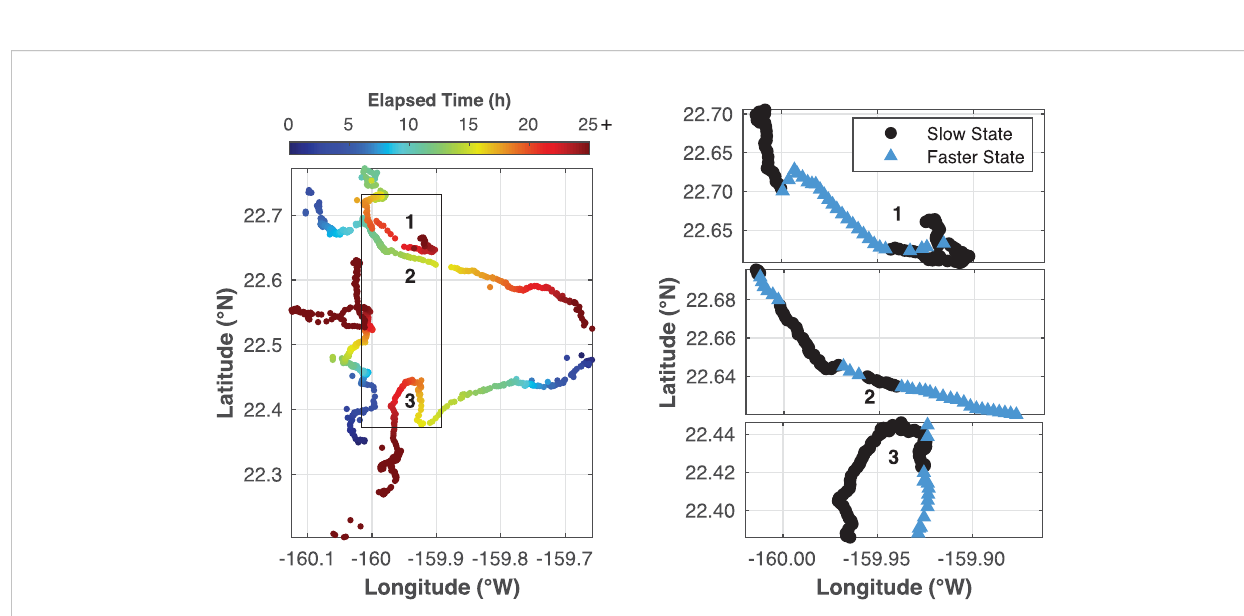
FIGURE 4 Four example minke whale tracks are shown using the original tracks (before CRAWL processing) for a 36 hour period as the whales traversed the range (left plot), with the boxed area indicating the focal study area. The sections of the tracks that are within the focal area are shown to the right for three of the tracks, with numbers 1 – 3 marking the three tracks in both plots. The west-most track is not shown in the right panel because the whale was moving in and out of the focal area. These positions are estimates of the original positions in evenly-spaced 5 min intervals derived from the CRAWL model with colors indicating kinematic state derived from the HMM model ( “ Slow State ” in black and “ Faster State ” in blue).